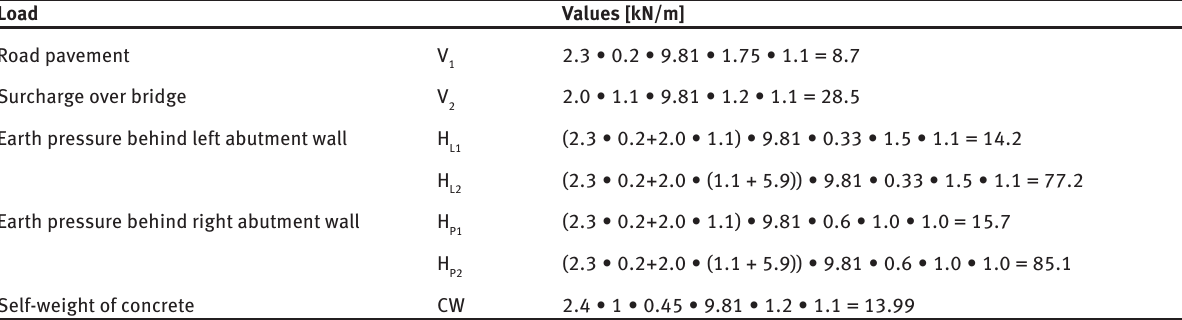
Table 3. Permanent load.